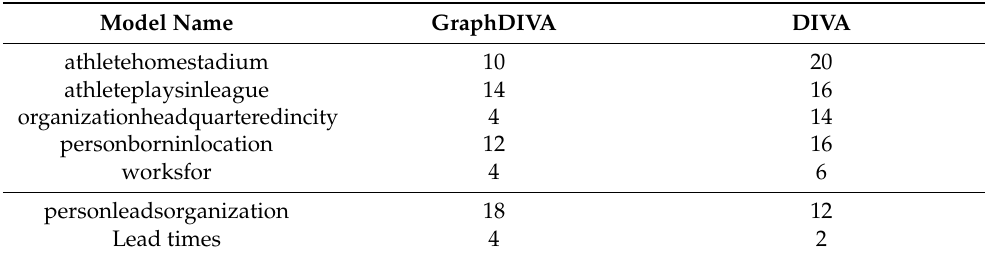
Table 7. Number of training sessions required to obtain the best results on